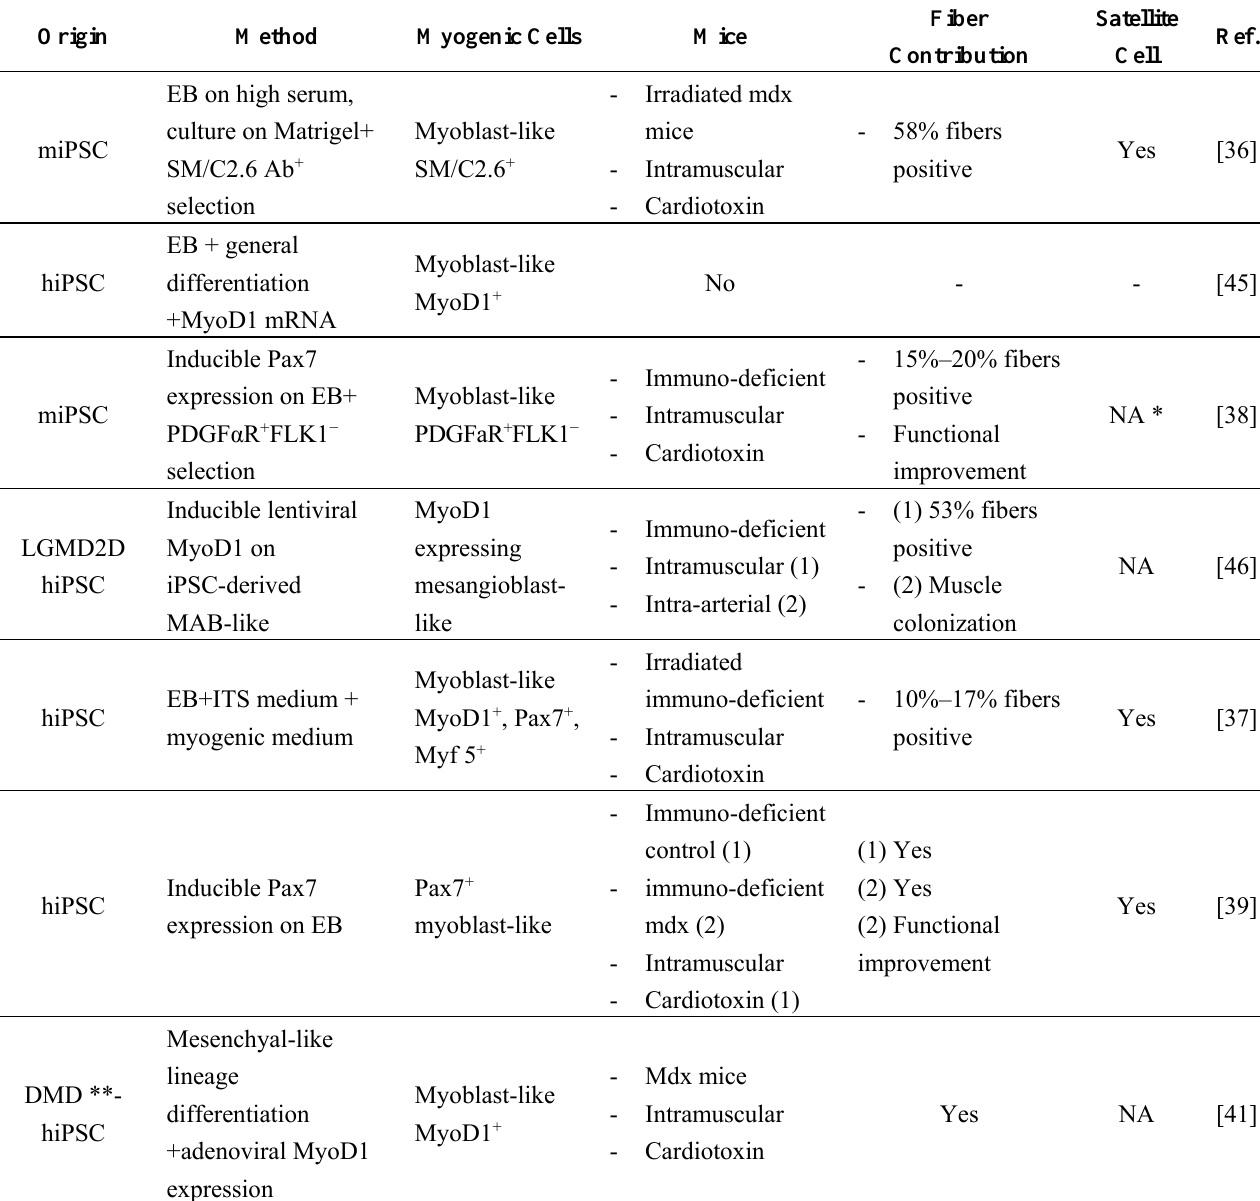
Table 2. Protocols for myogenic progenitor derivation from iPSC and in vivo testing.